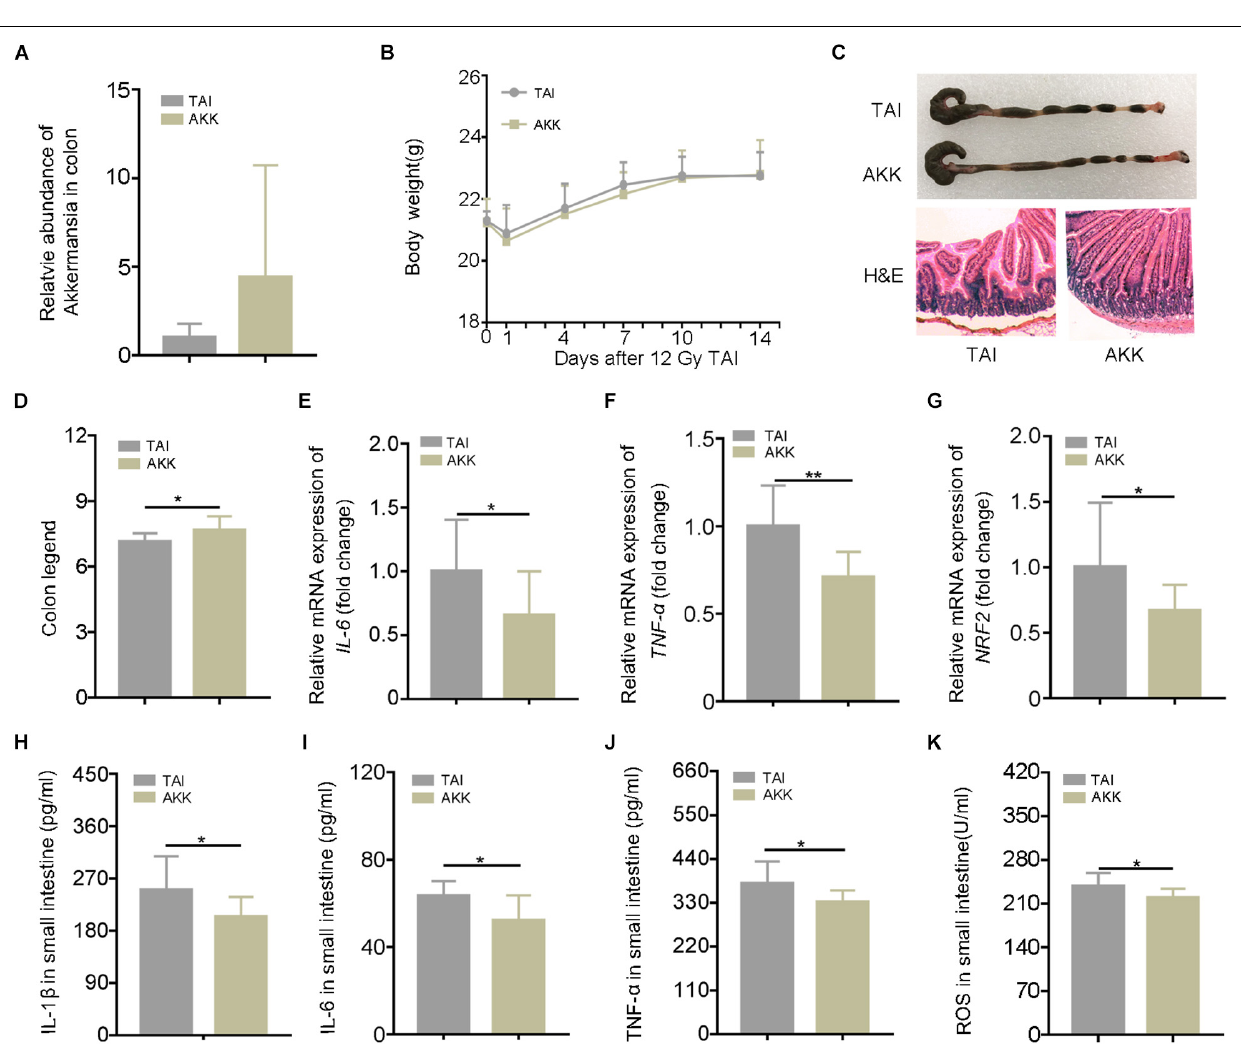
FIGURE 4 | Akkermansia muciniphila (AKK) mitigates radiation-elevated inflammatory status in digestive tract. Male mice were exposed to 12 Gy of TAI; and for AKK group, the male mice were orally administrated with A. muciniphila (1.5 * 10 8 CFU) for 15 days following radiation challenge, n = 10. (A) The relative abundance of A. muciniphila in the colon was detected by q-PCR. (B) The body weight of male mice in the two groups. (C) Photographs of dissected colon and morphology of the small intestine shown by H&E from male mice in the two groups. (D) Statistical results of colon length between two groups. (E–G) The expression levels of IL-6 , TNF- α , and NRF2 were examined in small intestine tissues from male mice by qRT-PCR. (H–K) The levels of IL-1 β , IL-6 , TNF- α , and ROS in the small intestine of male mice were measured by ELISA. Significant differences are indicated: * p < 0.05, and ** p < 0.01 by Student’s t -test between two cohorts. TAI, total abdominal irradiation; ROS, reactive oxygen